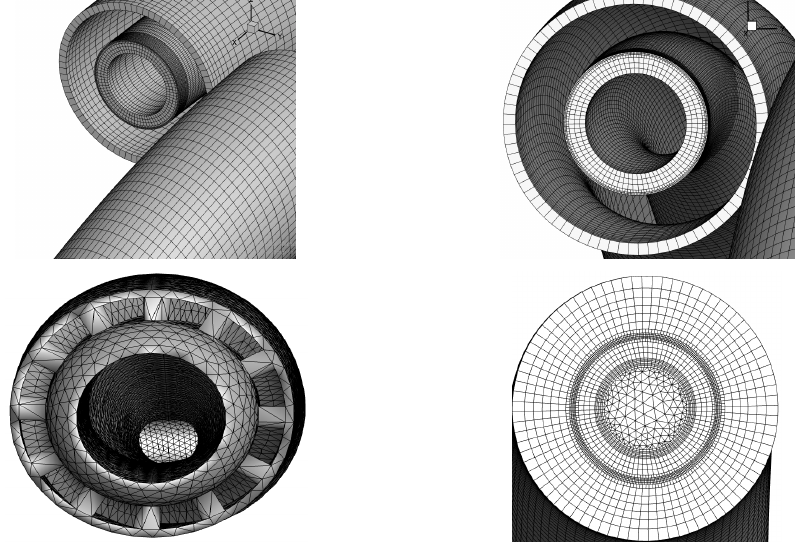
Figure 5. The pictures of the produced grid at various views of the proposed heat exchanger.